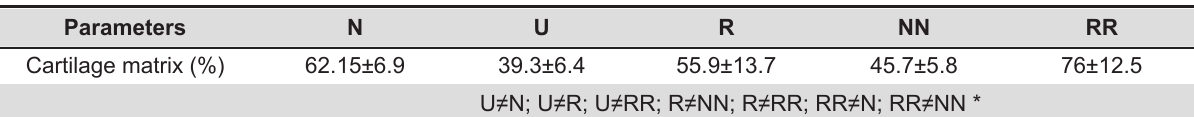
Table 2- Mean (±SD) of percentage of the cartilage content of the CP layers assessed in Safranin-O stained sections.